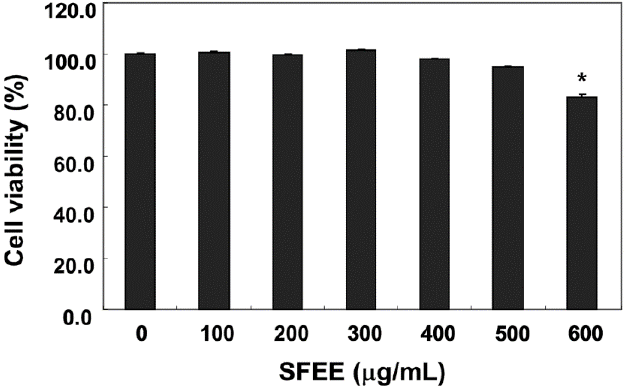
Figure 1. Effects of Schisandrae Fructus ethanol extract (SFEE) on C2C12 cell viability. The cells were treated with various concentrations of SFEE for 24 h. Cell viability was assessed using the MTT reduction assay. Data are mean ± standard deviation of three independent experiments. Differences were determined by Student’s t- test ( * p < 0.05